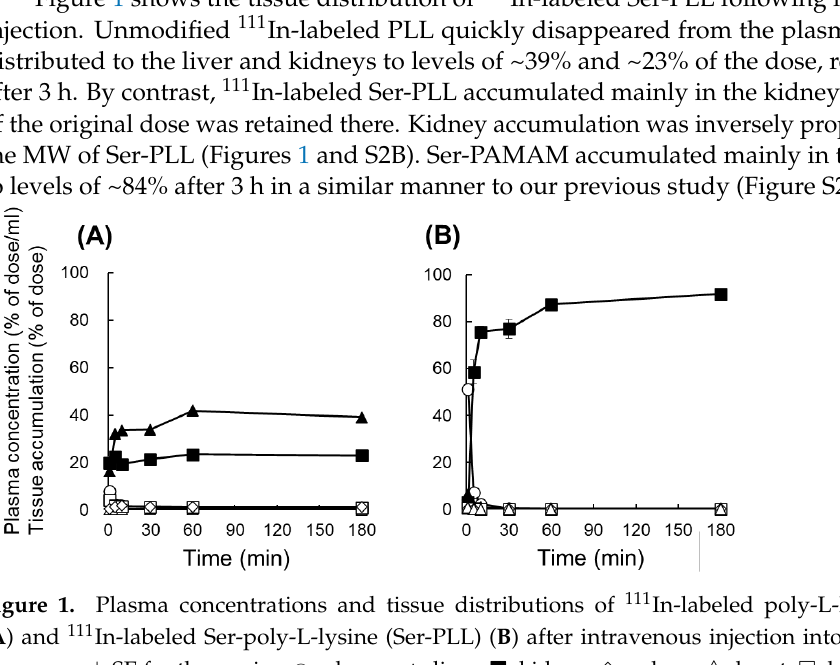
Figure 2. SPECT/CT imaging 180 min after intravenous injection of 111 In-labeled Ser-poly-L-lysine (Ser-PLL) in mice. ( A ) 3D imaging; ( B ) sagittal plane; ( C ) coronal plane; ( D ) transverse plane. 3.4. Intrarenal Distribution of FITC-Labeled Ser-Poly-L-Lysine An evaluation of the intrarenal accumulation by FITC labeling clearly displayed flu- orescence intensity derived from FITC-labeled Ser-PLL in the renal cortex (Figure 3A) but none in the renal medulla (data not shown). Enlarged microscopic images of the renal cortex exhibited high fluorescence intensity derived from FITC-labeled Ser-PLL in the proximal tubules (Figure 3B).